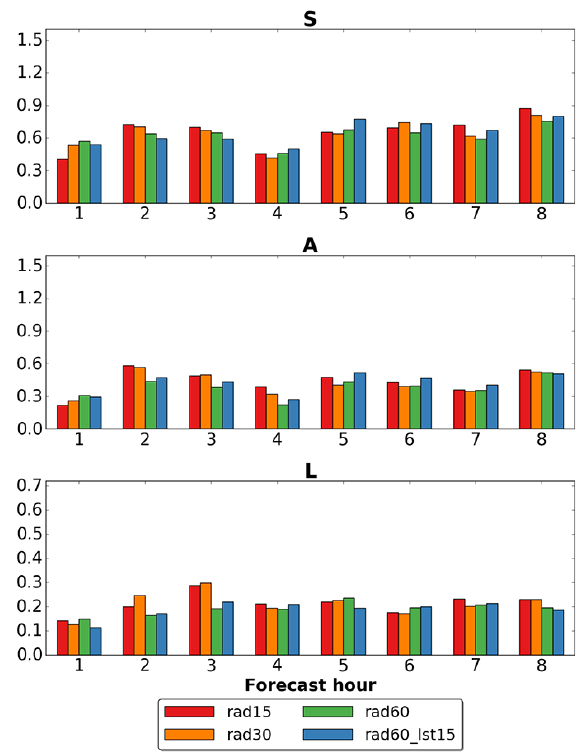
Figure 7. As in Fig. 5 but considering experiments rad15 (red), rad30 (orange), rad60 (green) and rad60_lst15 (blue).